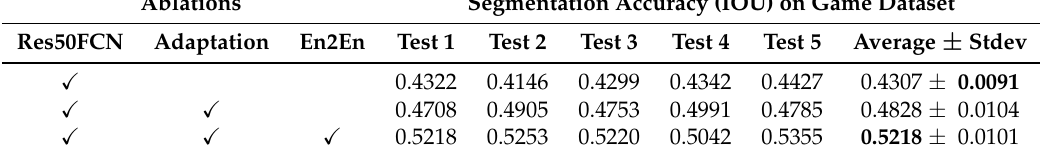
Table 4. Results of our ablation analysis on “domain adaptation” and “end-to-end training”. Res50FCN: our baseline method. Adaptation: the style transfer networks ( ˜ D , ˜ G ) and segmentation network F are separately trained. En2En: jointly train all networks in an end-to-end fashion. The integration of the domain adaptation and end-to-end learning yields noticeable improvements in the segmentation